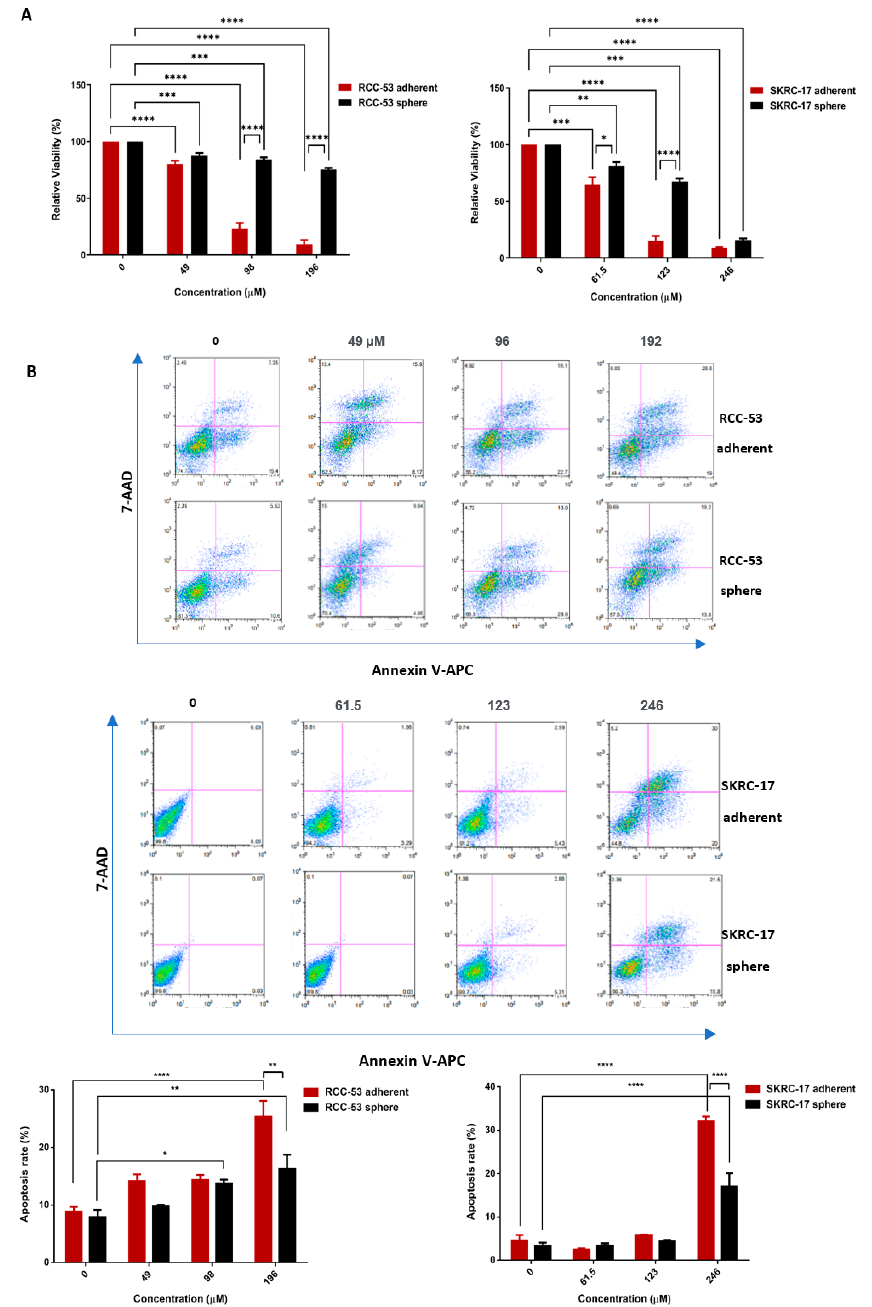
Figure 8. EGCG mediated the anti-tumor effect against SKRC-17, RCC-53, and their corresponding CSCs. ( A ) CellTiter-Blue Cell Viability Assay: EGCG suppressed the cell viability (shown for 48 h). ( B ) EGCG induced apoptosis, the apoptosis rate was calculated by Annexin V and 7-AAD positive staining using flow cytometry ( n = 3, * p < 0.05, ** p < 0.01, *** p < 0.001, **** p < 0.0001). 3.9. EGCG Inhibits Migration and Invasion of RCC-53 and SKRC-17 Cell Lines